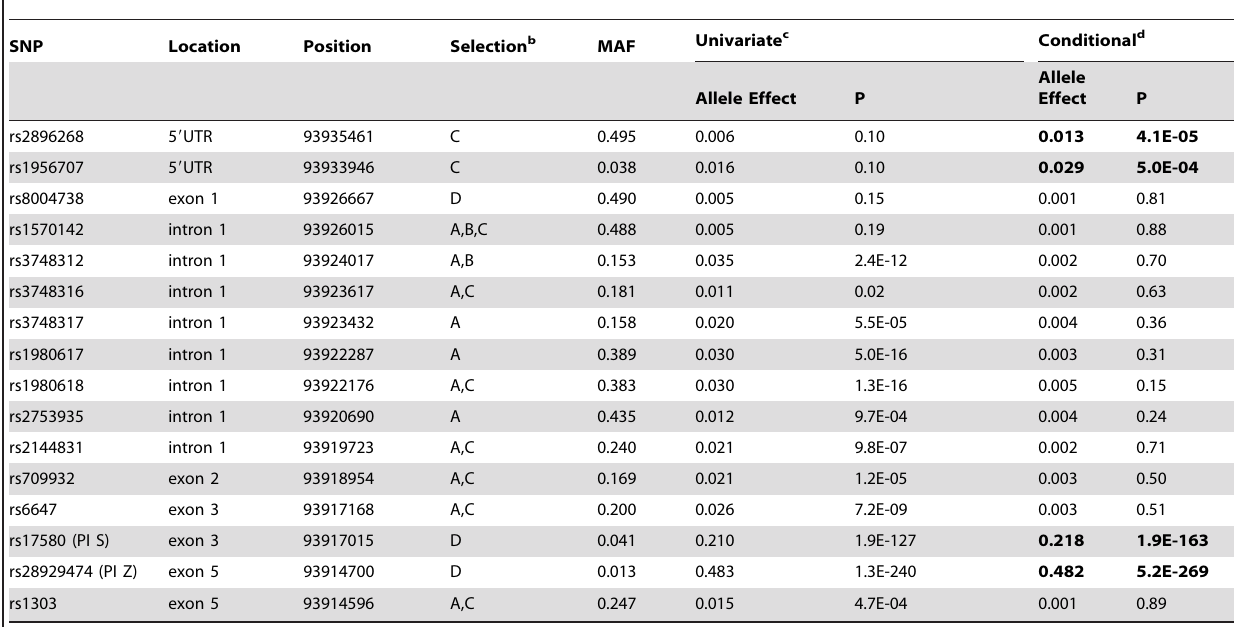
Table 4. Common and low-frequent SERPINA1 SNPs and their association with AAT serum level, univariate and conditional on significantly associated SNPs (N =5569 a ), in